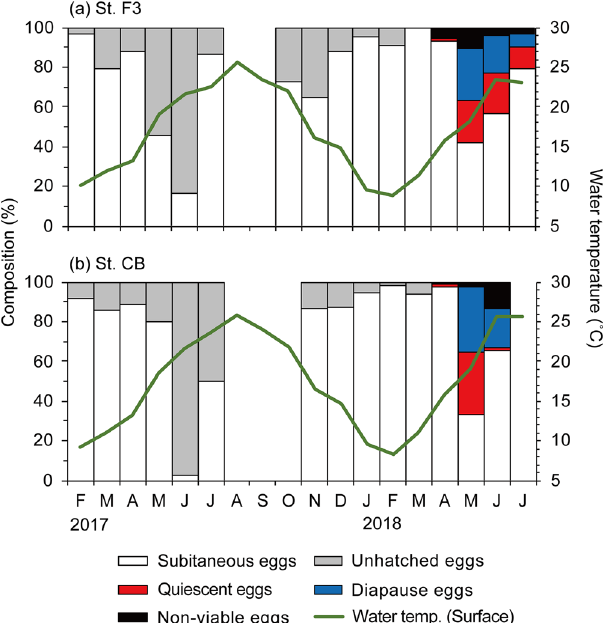
Figure 10. Seasonal changes in the composition of egg type in total produced eggs by Acartia omorii at St. F3 ( a ) and St. CB ( b ) from February 2017 through June 2018. Lines in both panels indicate surface water temperature.The non-viable, diapause and quiescent eggs were only investigated from April to June